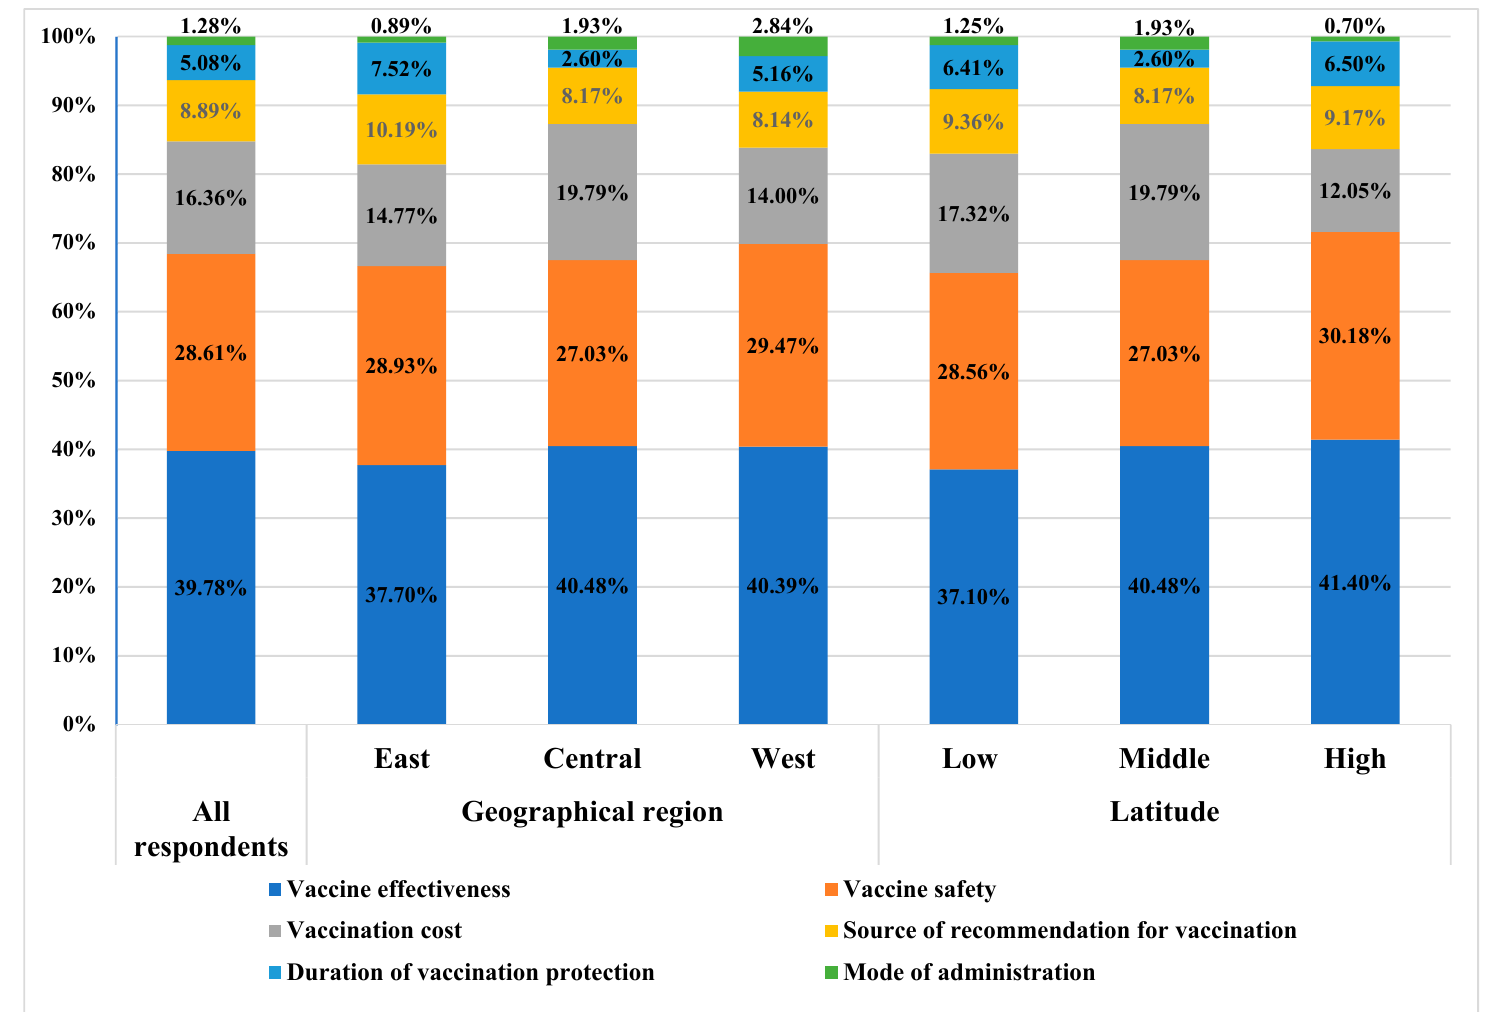
Figure 1. Relative importance of six attributes in all respondents and subgroups.